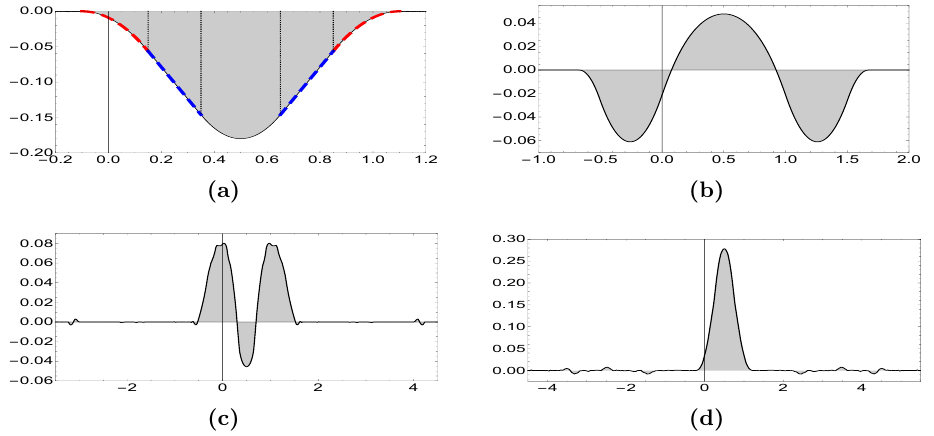
Figure 5. Numerical perturbed breather solution (shadowed region under solid line) and self- similar exact solution (dashed lines) for (cid:15) = 3 : 0. Snapshots correspond to (a) t = 0 : 15, (b) t = 1 : 01, (c) t = 8 : 96, (d) t = 21 : 23.